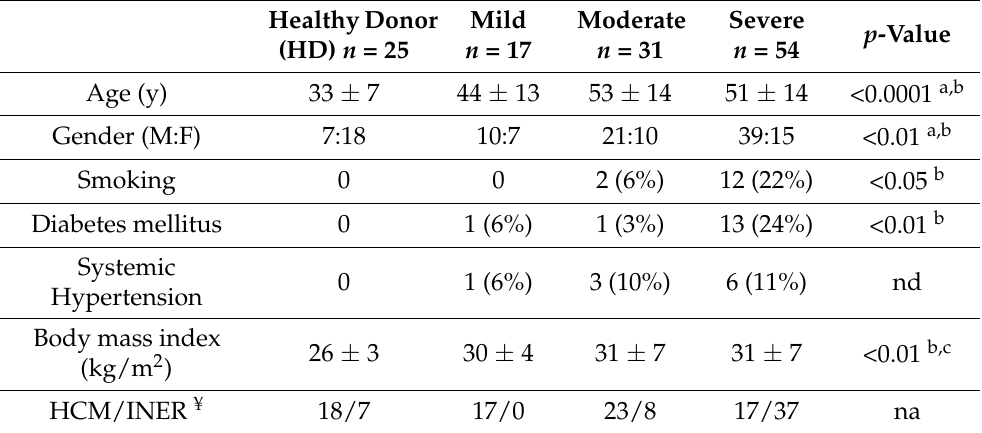
Table 1. Demographic and comorbid state.